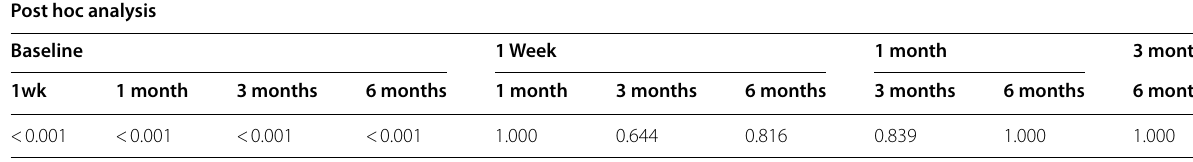
P -value > 0.05: Non-significant; P -value < 0.05: Significant; P -value < 0.01: Highly